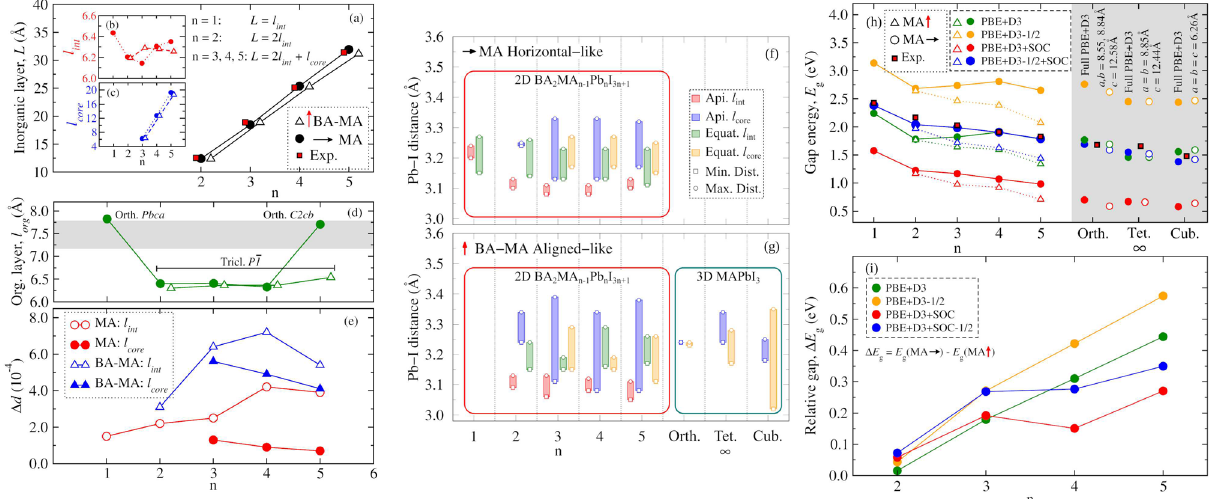
Figure 3. Thickness characterization of inorganic and organic layers through ( a ) L (complete Pb n I 3 n + 1 ), ( b ) l int (PbI 6 octahedrons at interface region), ( c ) l core (PbI 6 octahedrons at inorganic core region), and ( d ) l org (organic BA 2 width region). The red square symbols and shaded region are—respectively—the L and l org interval values experimentally reported 12,13 . ( e ) Bond length distortion ( (cid:31) d ) for the Pb n I 3 n + 1 layer at the interface and core regions. ( f ) MA horizontal-like and ( g ) BA-MA aligned-like values are depicted separately for the interface ( l int ) and core ( l core ) regions. ( h ) Band gap energies for MA horizontal-like and BA-MA aligned-like for 2D-RP perovskites calculated through the DFT-1/2 and SOC combinations and compared with the experimental values 12,13,22–25,67,68 . The same protocol set was employed for the orthorhombic, tetragonal, and cubic bulks fully relaxed and for relaxed atomic positions into experimental lattice parameters; see the values indicated. ( i ) Relative gap calculated as � E g = E g ( MA → ) − E g ( MA ↑ ) between the MA horizontal-like and BA-MA aligned-like values for n =